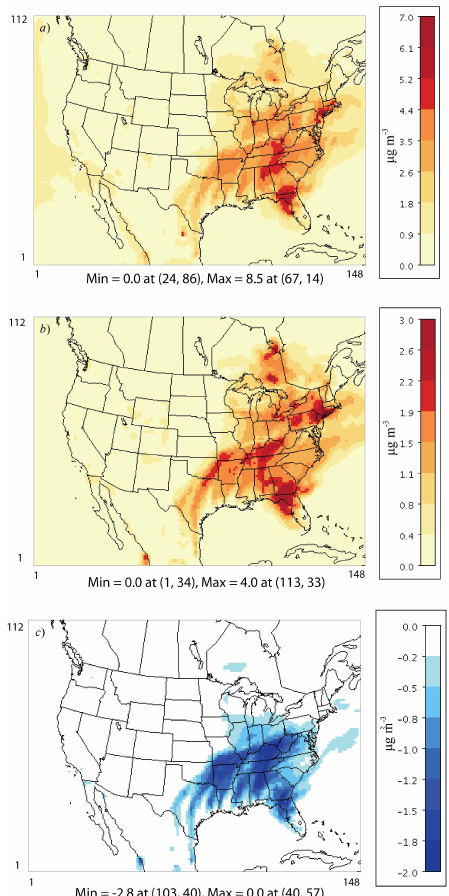
Fig. 4. Spatial distribution of 24-h averages of (a) simulated con- centration of sulfate, (b) first- and (c) second-order sensitivities of sulfate to SO 2 at surface layer on 3 January